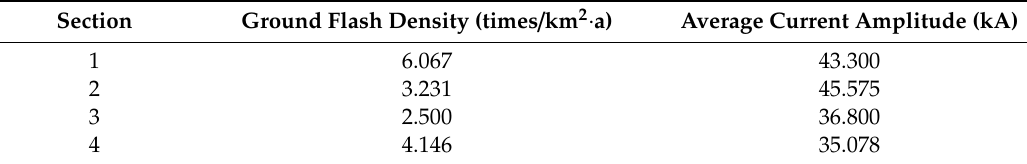
Table 1. Ground flash density and average current